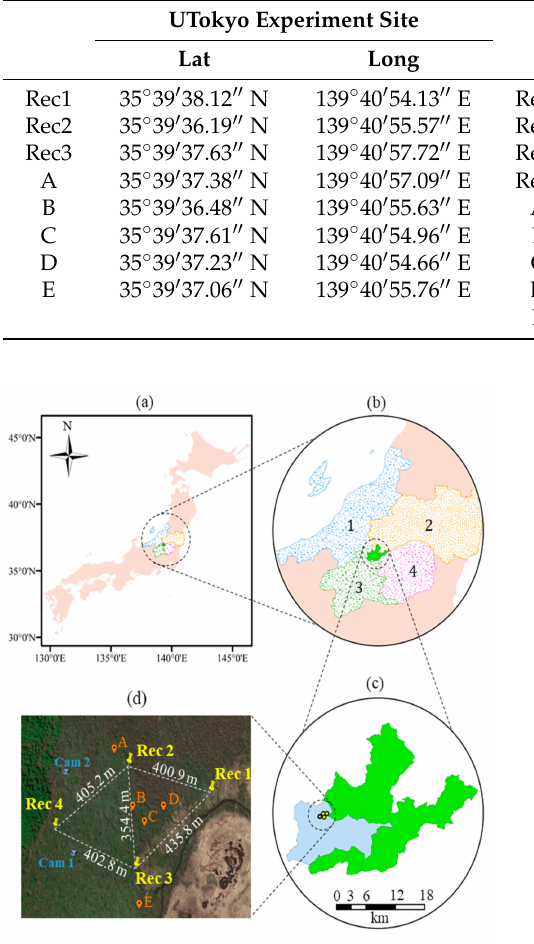
Figure 2. Location of recorders installed in Oze marshland. ( a ) Location of Oze National Park in central Japan; ( b ) location of Oze National Park with respect to four Japanese prefectures (i.e., 1-Niigata, 2-Fukushima, 3-Gunma and 4-Tochigi); ( c ) special protected area of Oze National Park (in blue); and ( d ) Google Earth image indicating location of recorders (Rec 1–4), distance between recorders, locations of two camera traps (Cam 1 and 2) and locations of validation points (A–E) where deer calls were emitted using a deer